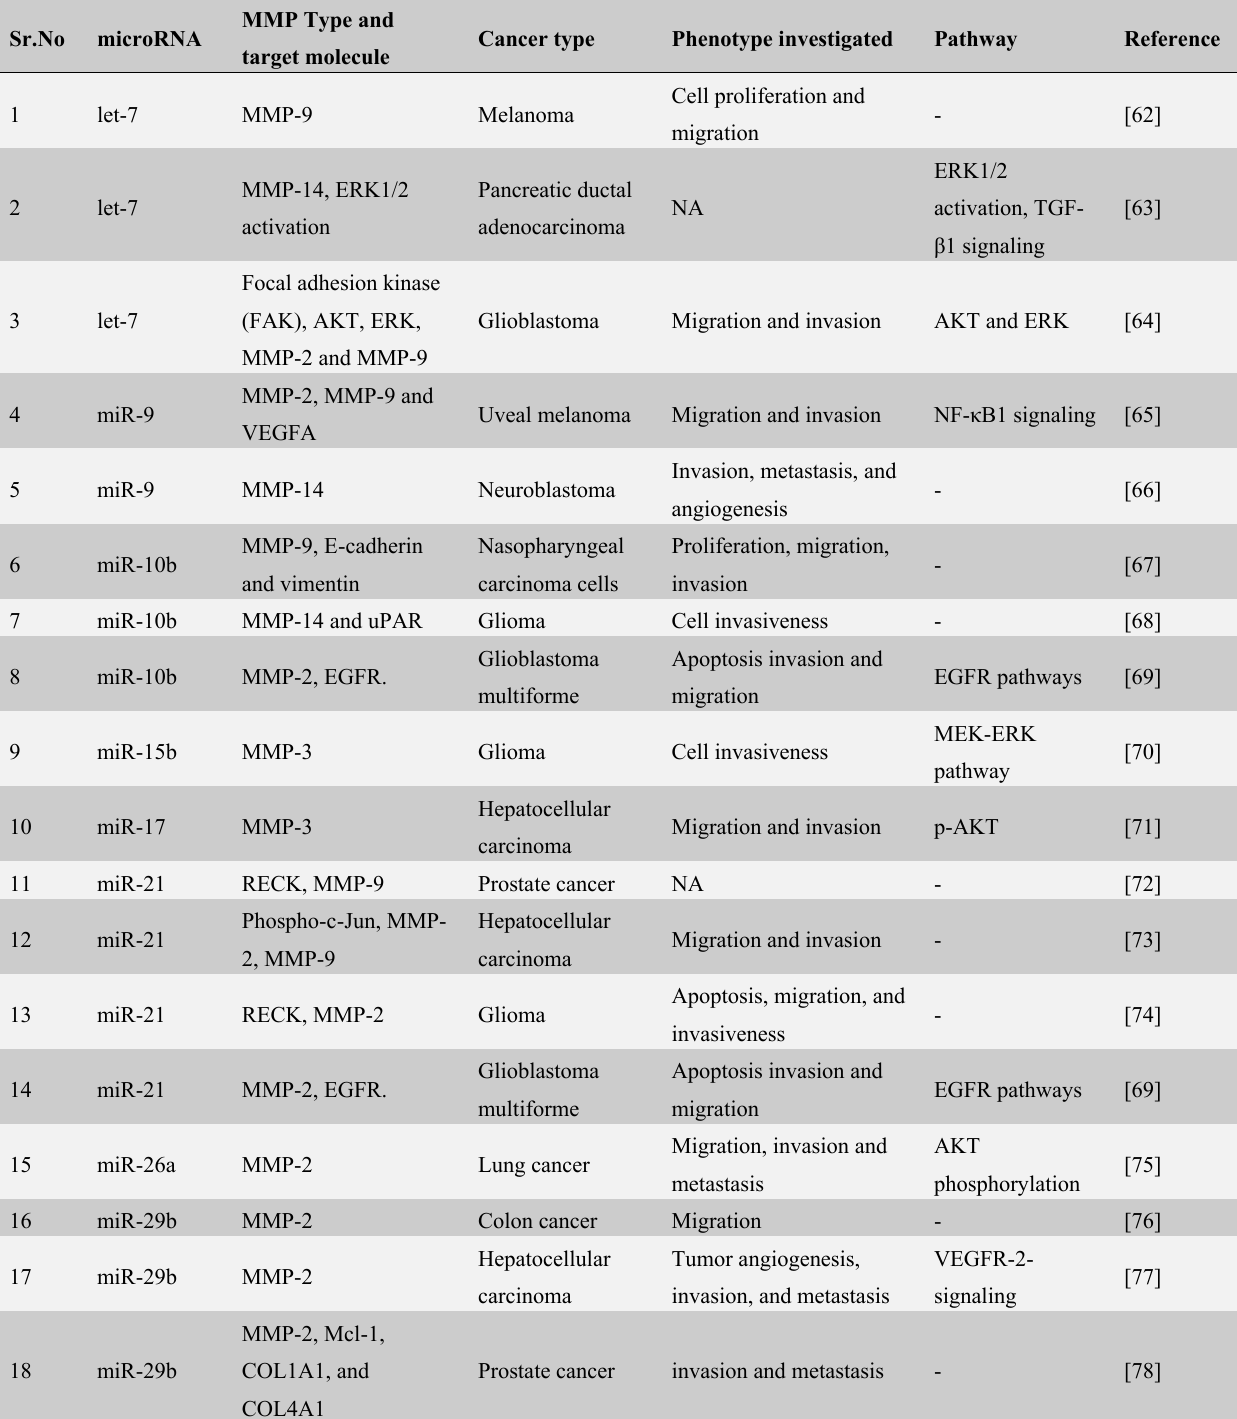
Table 1. Summary of microRNA/MMP linked interactions in cancer: Individual microRNAs and targeting MMPs directly or indirectly via other proteins leading up to cancer progression and metastasis in different cancer entities are outlined. Also included the possible pathways implicated in the mediation of observed